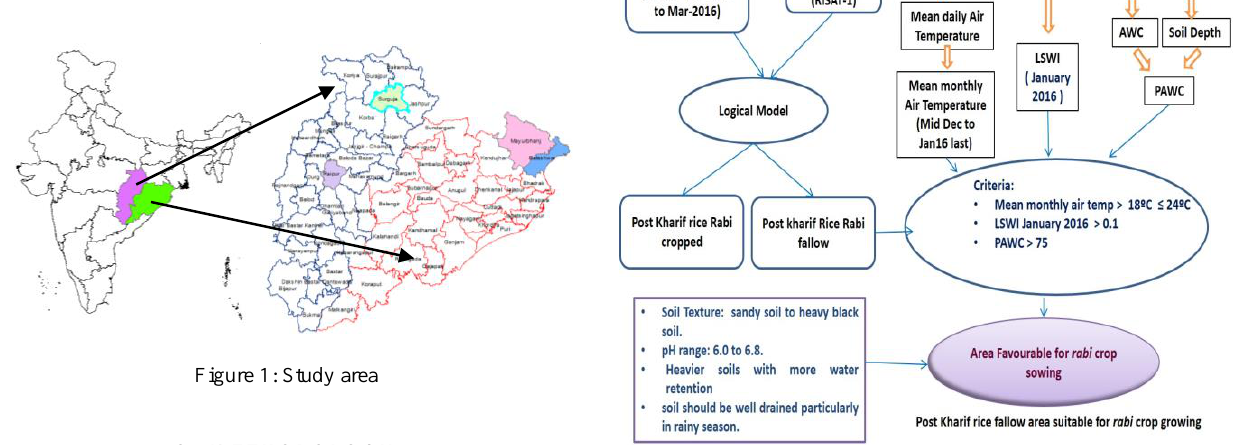
Figure 2: Methodology for post kharif -rice fallow area